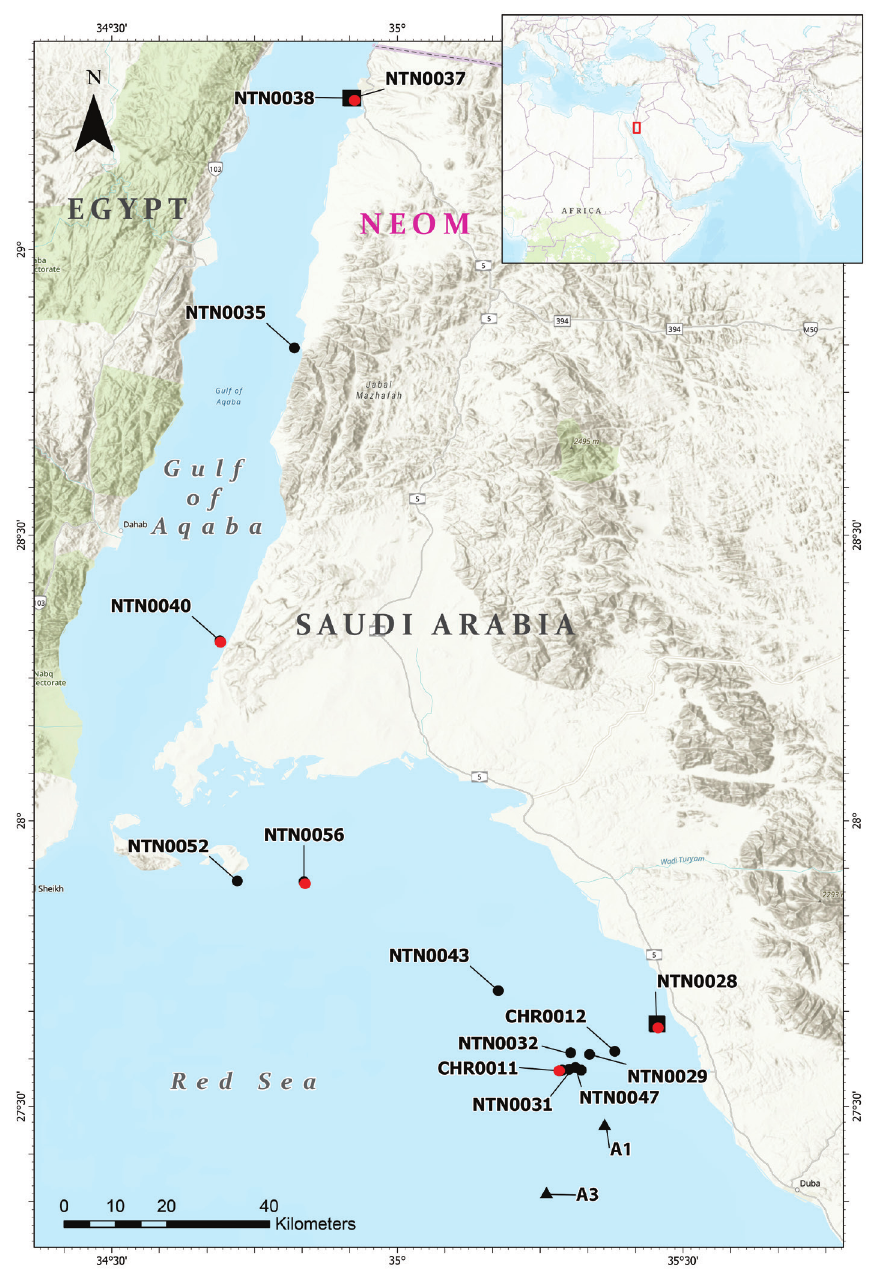
Figure 1. Map of the study area showing the known occurrences of Bathypathes thermophila sp. nov. Black dots: observed colonies during the 2020 OceanX-Neom Red Sea Expedition; red dots: sampled colonies; triangles: photographic record by Qurban et al. (2014). Black squares indicate the occurrence of an aggregation of colonies. Codes indicate the submersible (NTN) or remotely operated vehicle (CHR) dives. Coordinates and depth ranges for each dive are reported in Suppl. material